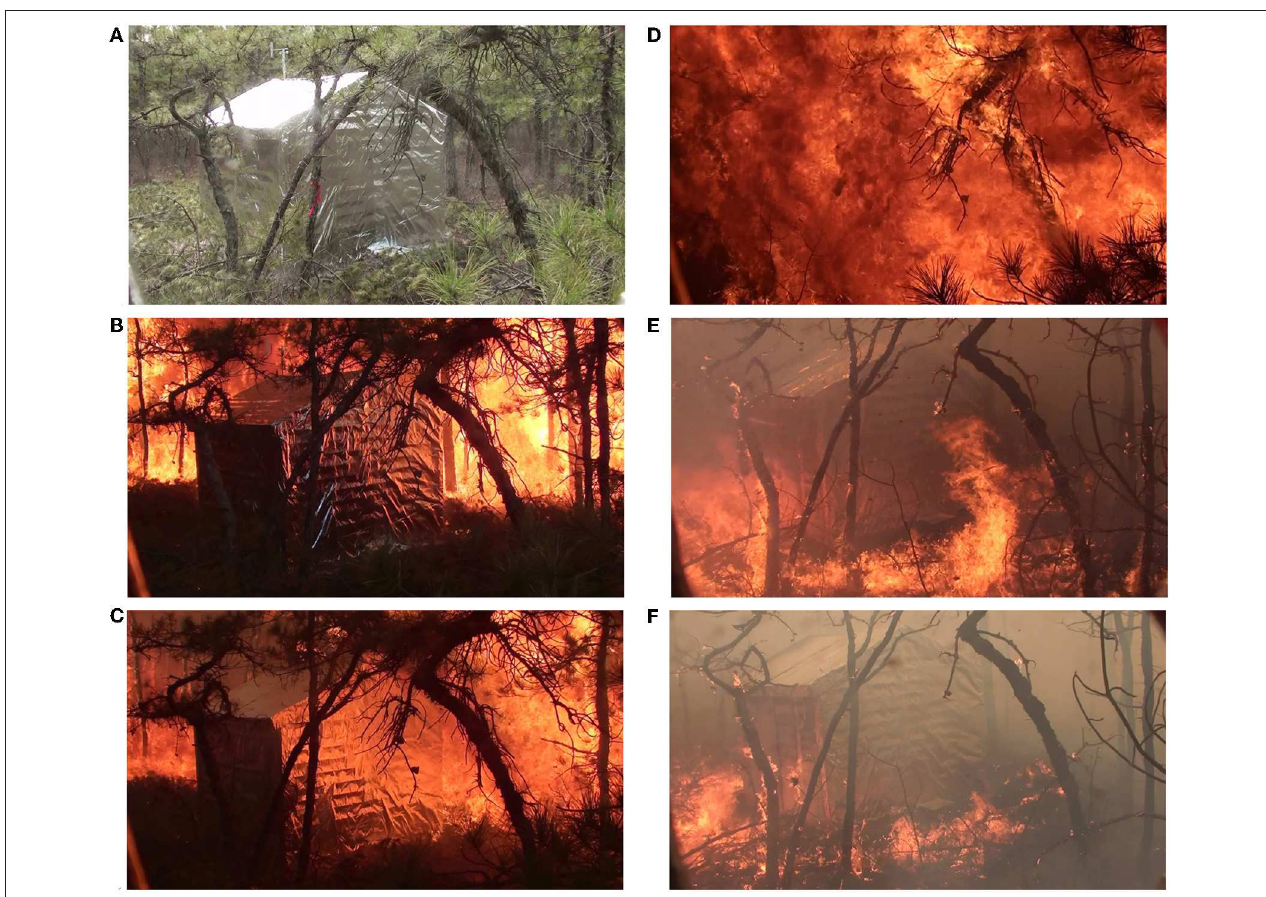
FIGURE 9 | Video images from the northeast side captured the fire front approaching from the east side and passing over the blanketed wood structure in a few minutes (see Supplementary Video 3 ). (A) The fire front is still ∼ 20 m away, (B) approaching, (C) arriving, (D) engulfing, (E) passing the shed, and (F) additional fuels continue to